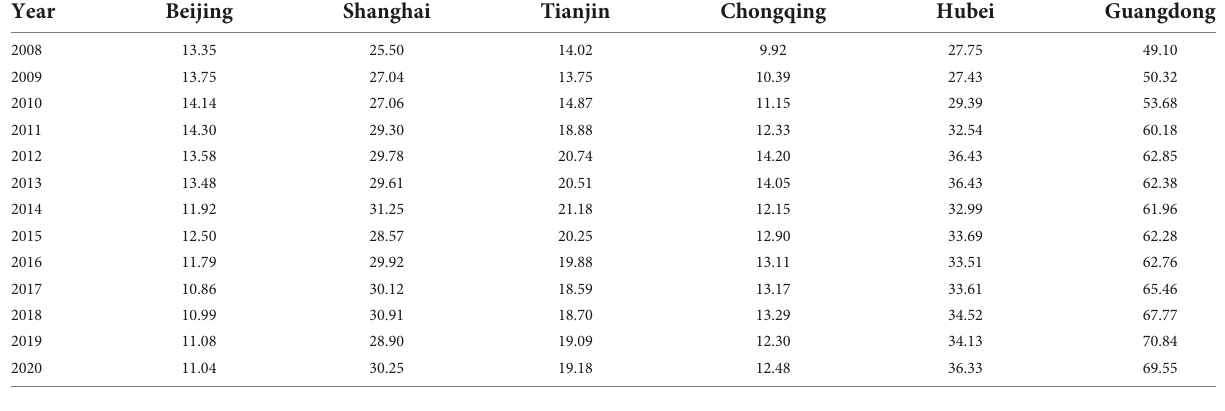
TABLE 2 Carbon emissions in the pilot provinces from 2008 to